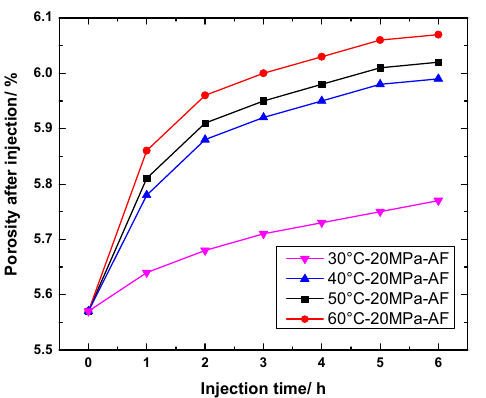
Figure 7. Variation in porosity with time for AF specimens at different temperatures under the same pressure of 20 MPa.